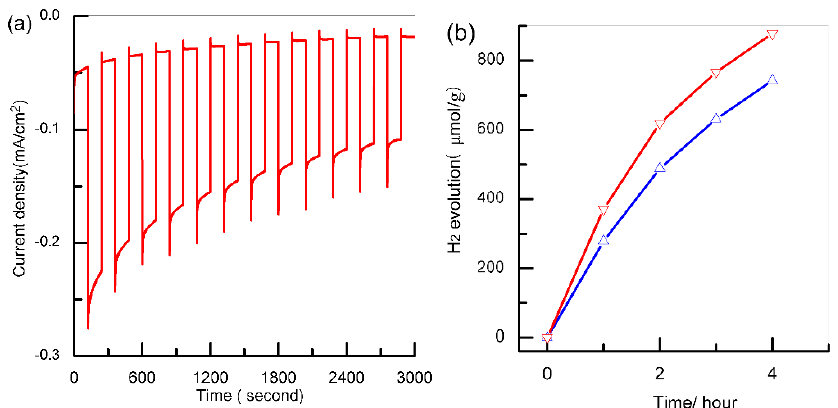
Figure 6. ( a ) Chopped photocurrent vs. time curve at 0.6 V vs. RHE; ( b ) the time courses of H 2 evolution under AM 1.5 with methanol as a sacrificial reagent (blue and red lines represent before and after depositing Pt).